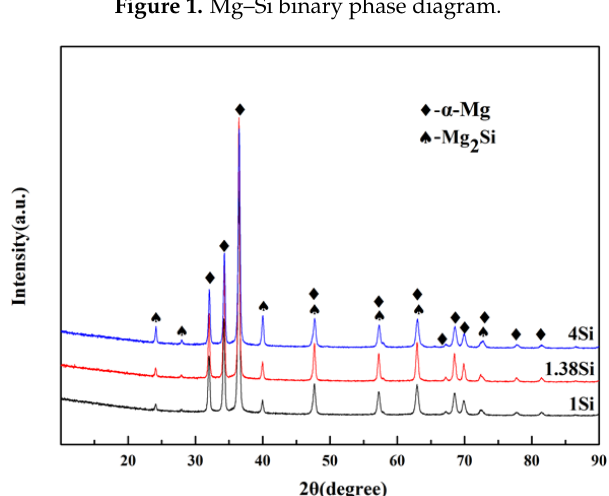
Figure 2. The XRD pattern for Mg – Si binary alloys.